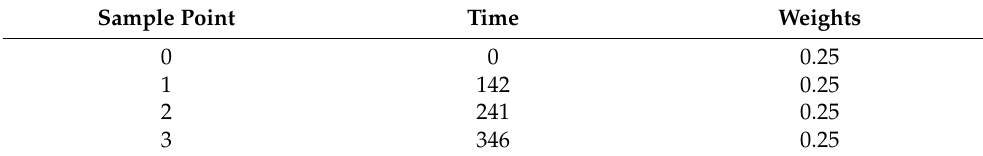
Table 2. Results of the optimal sampling points obtained using a D-optimal design